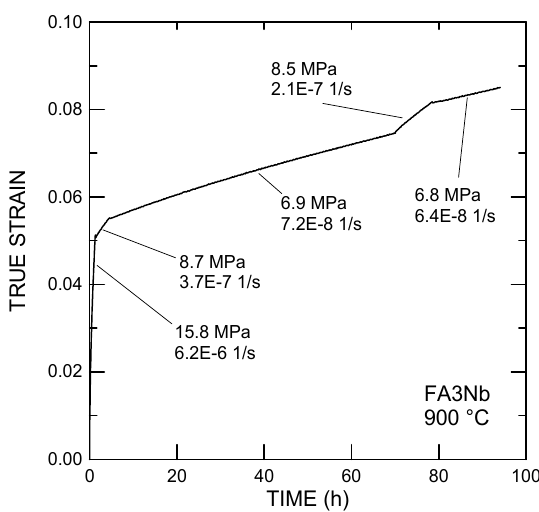
Figure 2. Example of a creep curve of the FA3Nb alloy at 900 °C showing five different segments with corresponding applied stresses and creep rates.